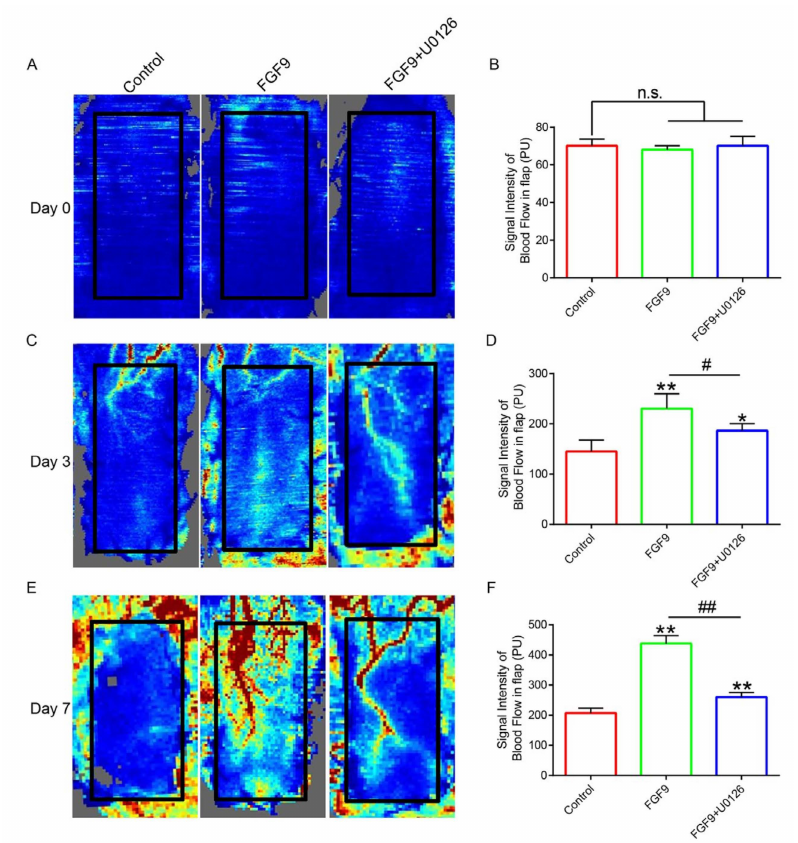
Figure 2. FGF9 accelerates blood flow reconstruction of flap. ( A , C , E ) The LDBF technique indicated the immediate postoperative subcutaneous blood flow, as well as three and seven days after surgery. ( B , D , F ) The statistical results of blood flow signal intensity of skin flap in the control group, FGF9 group and FGF9+U0126 group at 3 and 7 days after operation l (3 days: 142.67, 228.33, and 180; 7 days: 209.00, 456.00, and 256.67). The data are reported as the mean values ± SD, n = 3. * and ** indicate p < 0.05 and p < 0.01 against the control group, respectively; # and ## indicate p < 0.05 and p < 0.01 comparing the FGF9 group to the FGF9+U0126 group, respectively, demonstrating statistical significance. n.s. represents not statistically